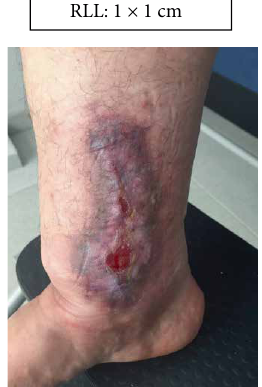
Figure 15: Week 9. Lower right limb.